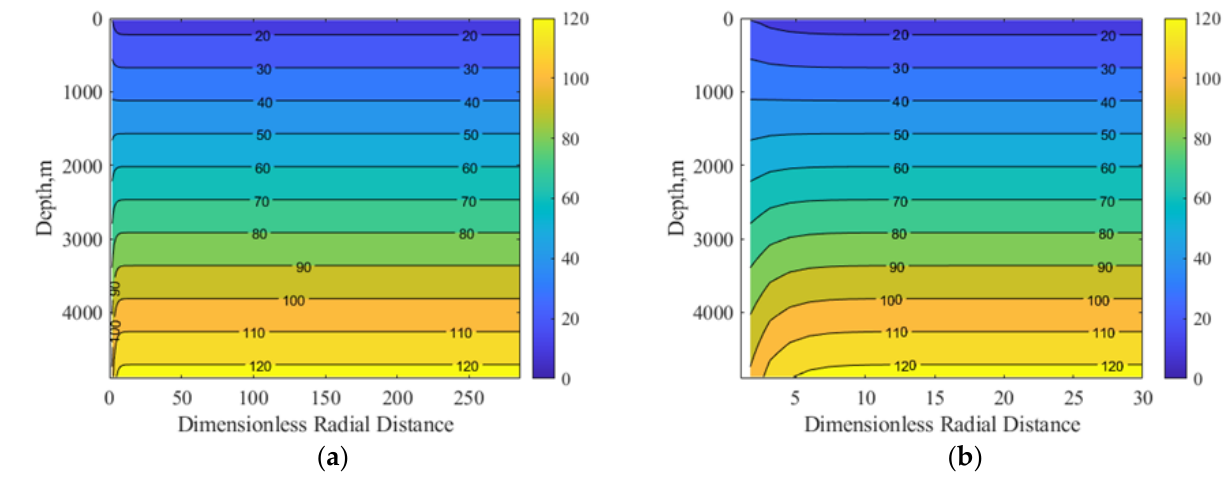
Figure 6. Temperature profiles: ( a ) a whole radial range and ( b ) an enlarged version.